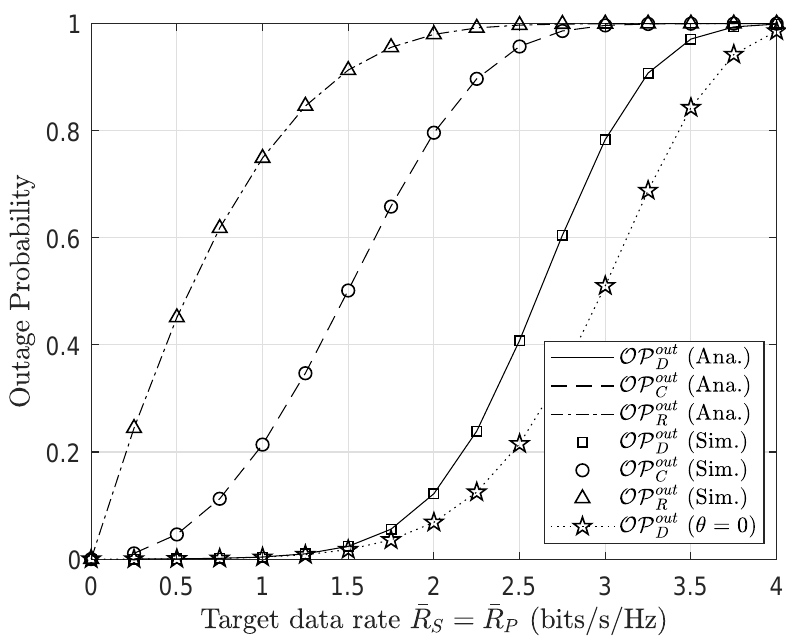
Figure 4. Outage performance versus the primary/secondary data rates ¯ R P , ¯ R S (bits/s/Hz).